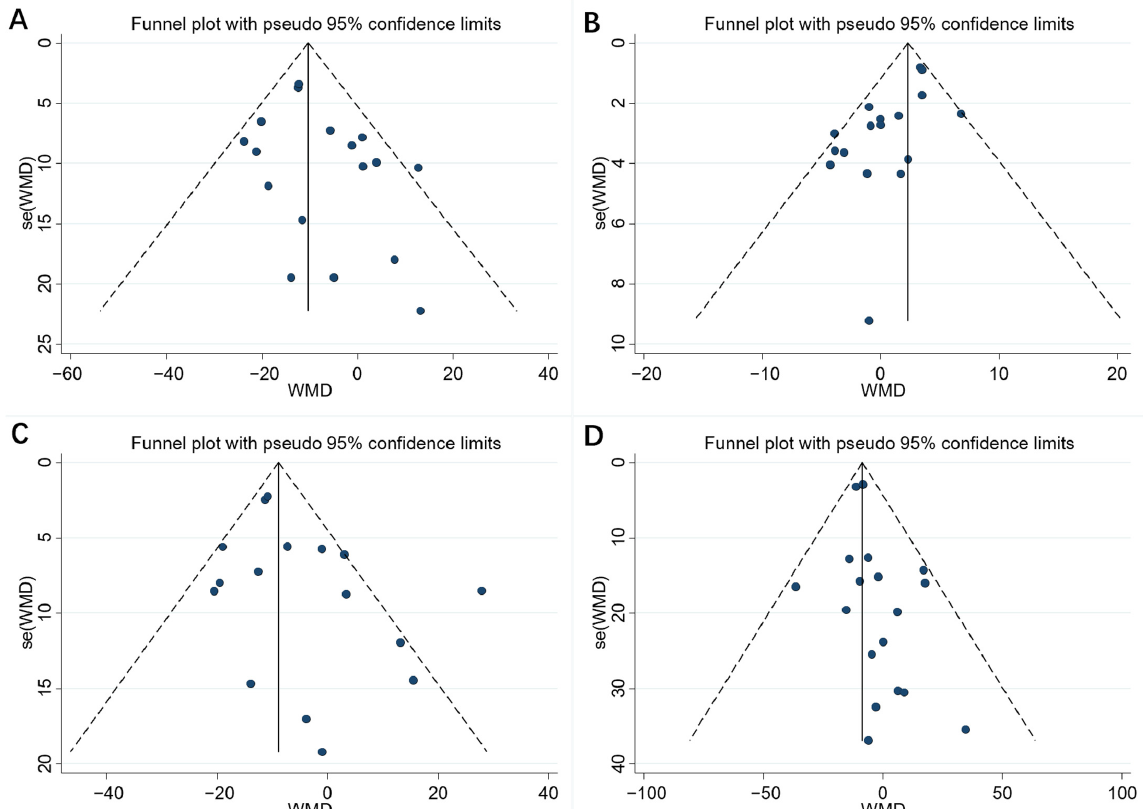
Figure 5. Funnel plots to evaluate publication bias, and effect of resveratrol for ( A ) TC Egger’s test ( p = 0.134), ( B ) HDL-C Egger’s test ( p = 0.03), ( C ) LDLC Egger’s test ( p = 0.115), and ( D ) TG Egger’s test ( p = 0.104). A = TC; B = LDL-C; C = HDL-C; D = TG. TC = Total cholesterol; HDL-C = High-density lipoprotein cholesterol; LDL-C = Low-density lipoprotein cholesterol; TG = Triglyceride. The black dots in the funnel plot represent the studies that were included. The larger the sample size, the smaller the standard error and the higher the distribution. Conversely, the smaller the sample size, the larger the standard error and the higher the distribution.